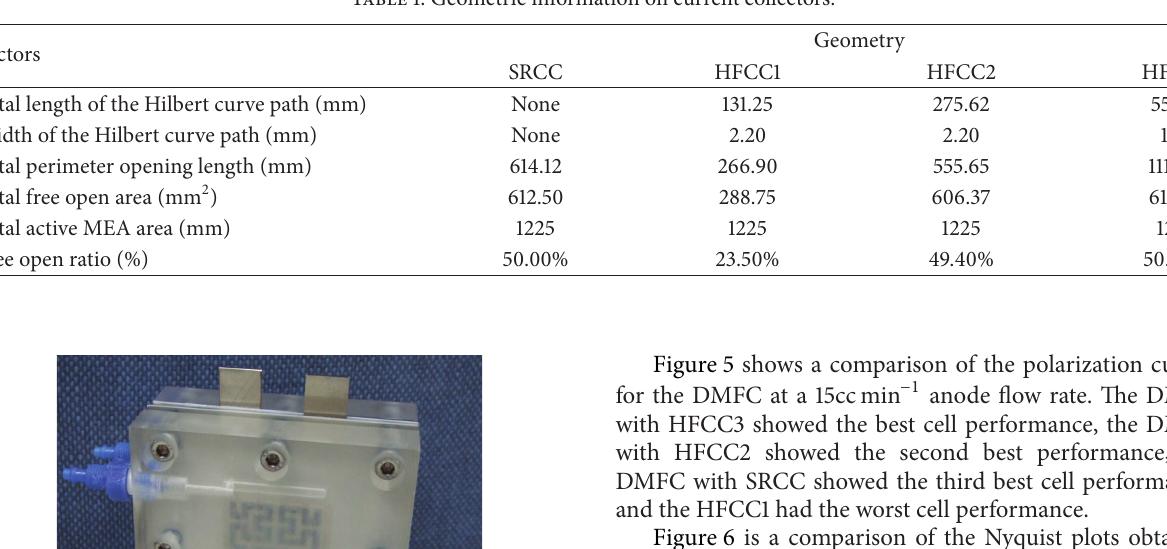
Table 1: Geometric information on current collectors.